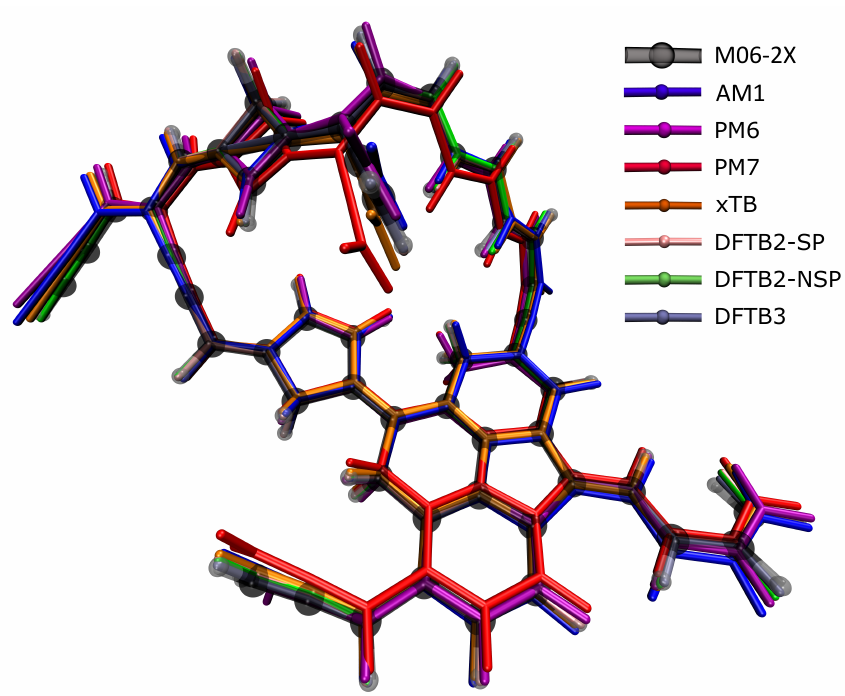
Figure 3. The soot structure with 50 carbon atoms in the figure was optimized using different calculation methods. The calculation result of M06-2x (translucent structure) was used as a reference. Other methods are represented by different colors. It is to be judged whether the method is suitable for optimizing the molecular structure of